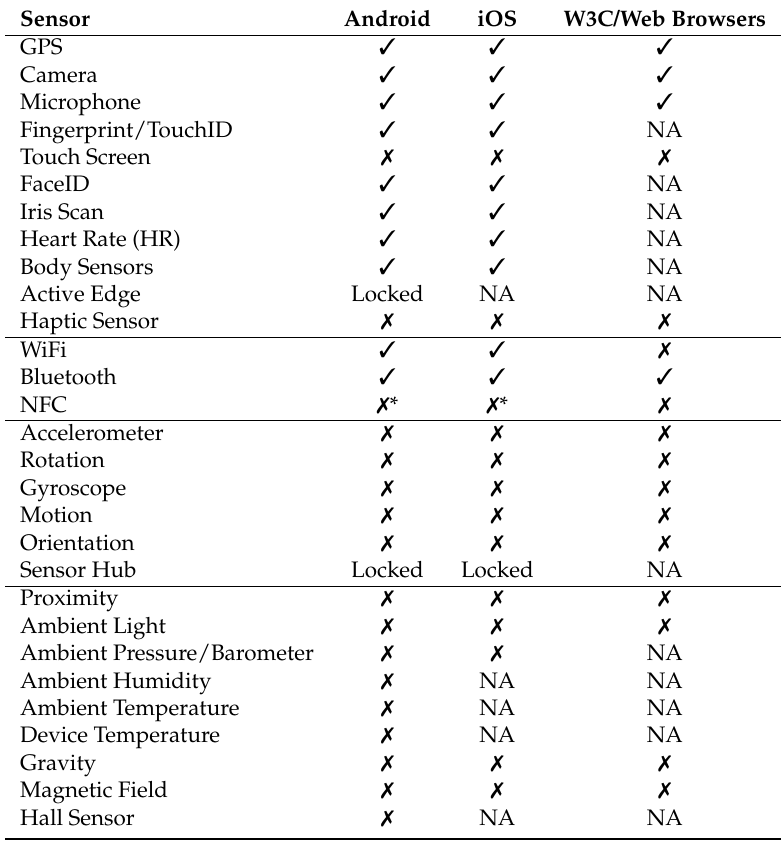
Table 2. Current permission policies of sensors on different platforms. (cid:51) : permission required, (cid:55) : permission not required, NA: not supported, and Locked: not open to developers. * NFC should be turned on manually for any program to be able to use